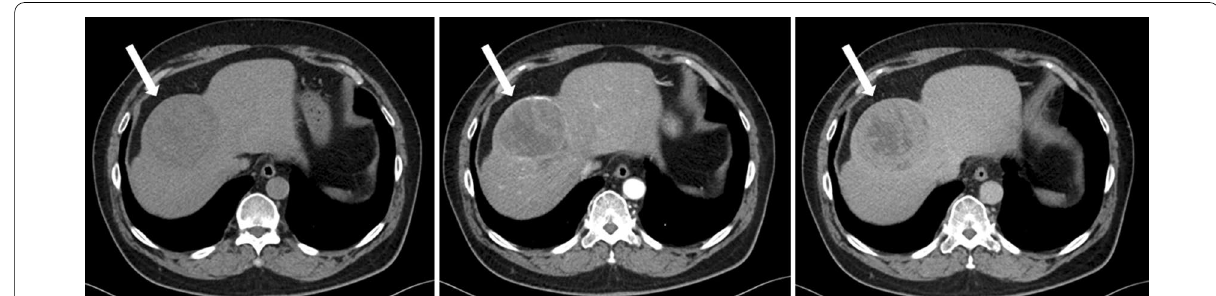
Fig. 1 Abdominal computed tomography (CT) images. Contrast-enhanced computed tomography revealed a tumor in segment 8 of the liver. The tumor was 80 mm in diameter and was adjacent to the middle hepatic vein. The white arrow indicates the tumor. Left: plain; middle: arterial phase; right: portal or delayed